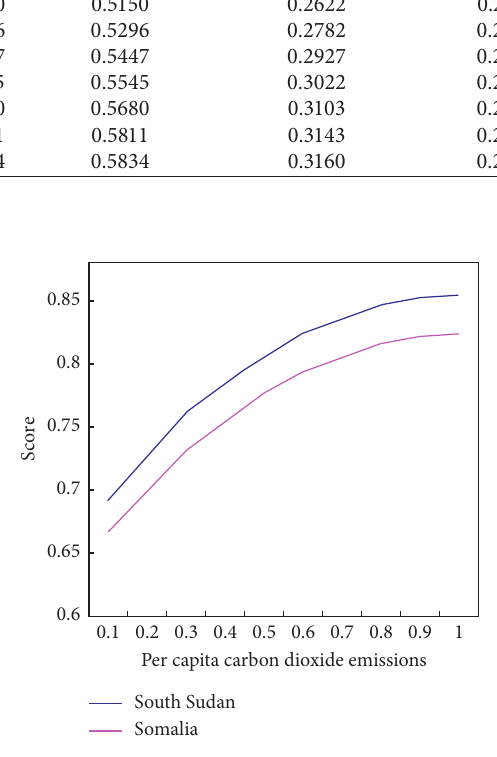
Figure 6: Score of fragile